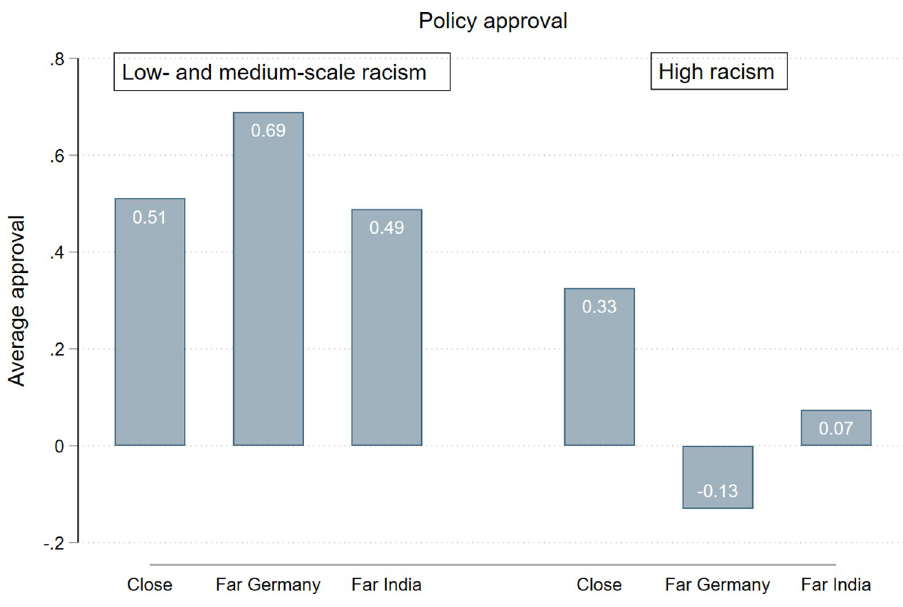
Fig 3. Different reaction patterns (policy approval) to the treatments depending on racist attitudes. The scale shows the average agreement to 12 policy measures (2 = full approval to -2 = full